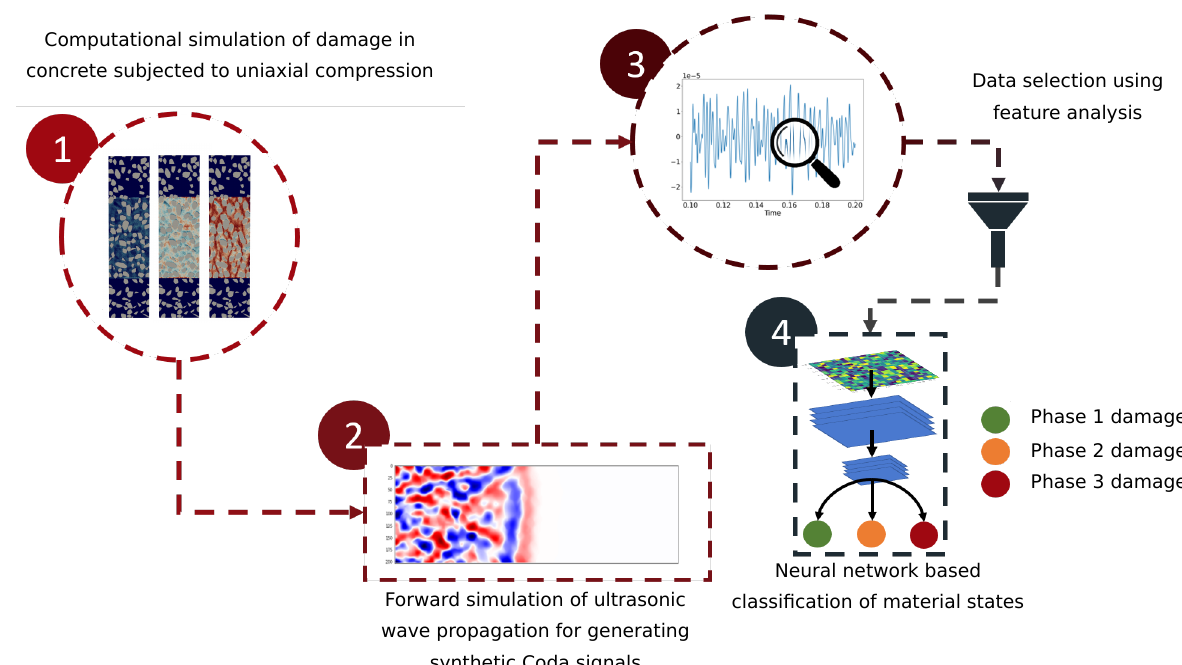
Figure 1. Workflow of the simulation-based procedure to detect damage in concrete specimens subjected to uniaxial compressive